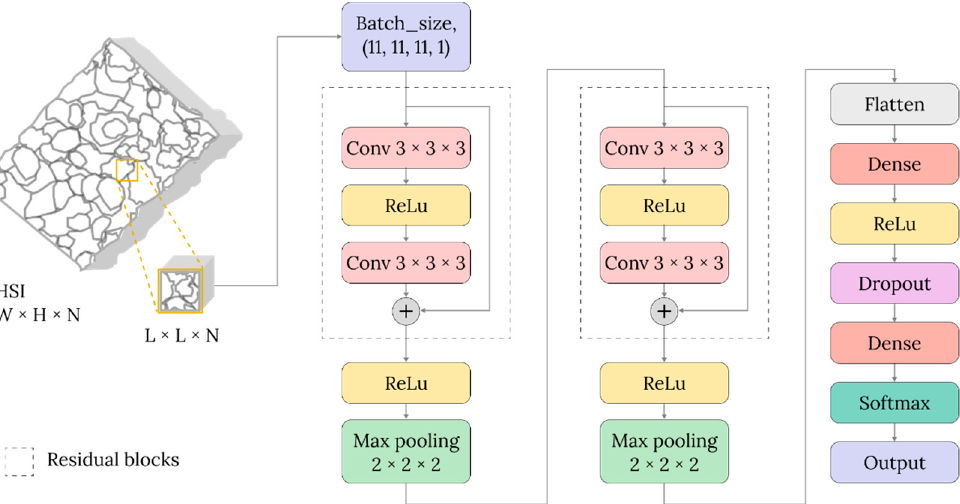
Figure 10. Hyperspectral images divided into small patches by Yu et al. (2021) [81] to decrease the input size and increase the number of datasets.